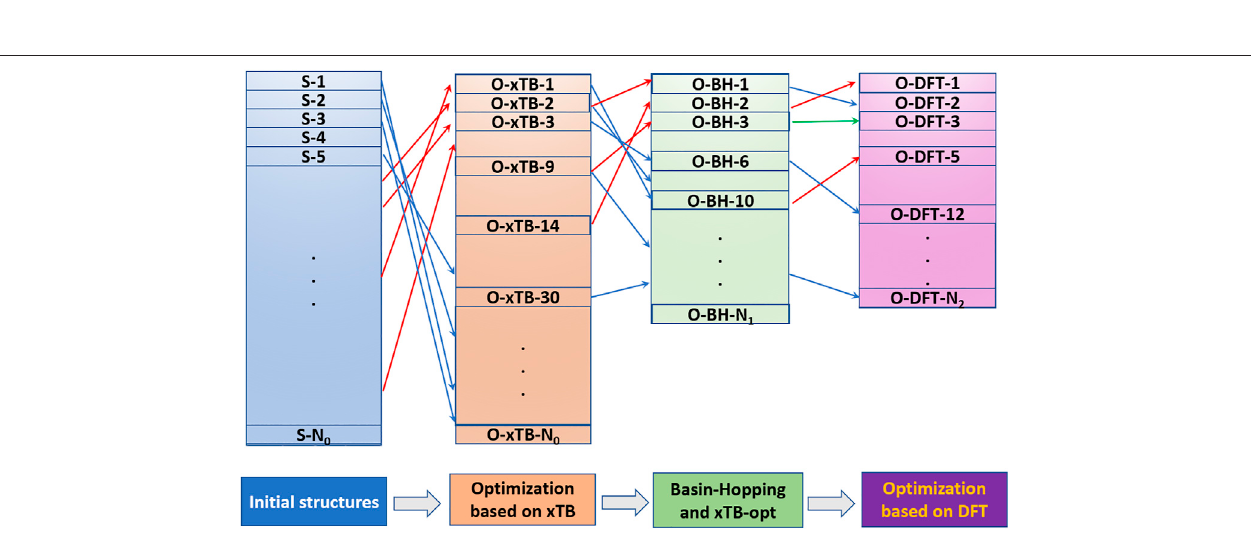
FIGURE 2 | The process for searching the global minimum by the NKCS